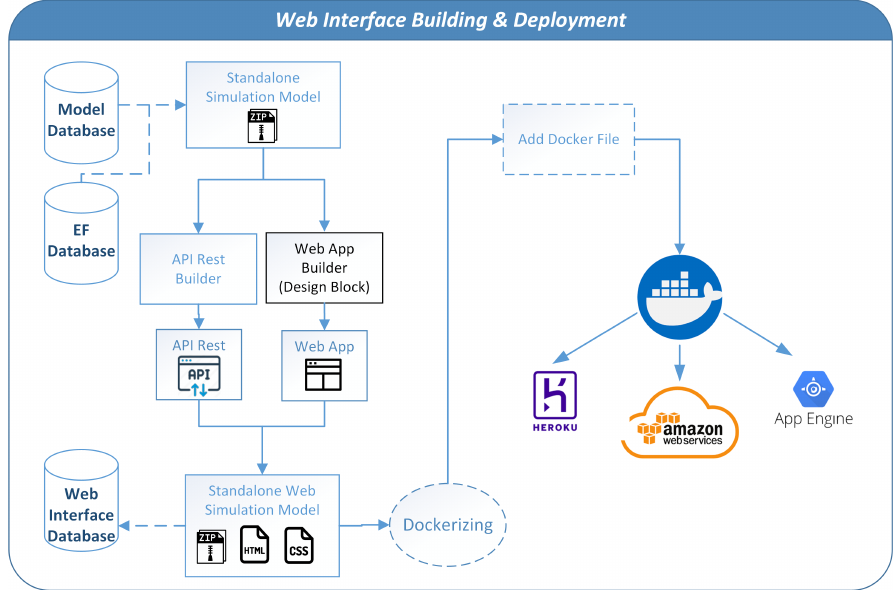
Figure 5. Construction of the web interface of a simulation model from its standalone version, which is a compressed package that includes the DEVS simulation model with its experimental frame (EF) and its simulator. The process of building the web application (in black) that allows the simulation model to interface with a graphical application is detailed below. The web interface (REST API or web app) is stored in a database. It will only be published via Dockerization [36] if the developer wants it. Dockerization is a process that creates an isolated container of the standalone simulation model and its web interface, which can then be easily exposed on a web application service such as Heroku or Google App Engine. This process requires the addition of a Docker file to the source codes of the standalone simulation